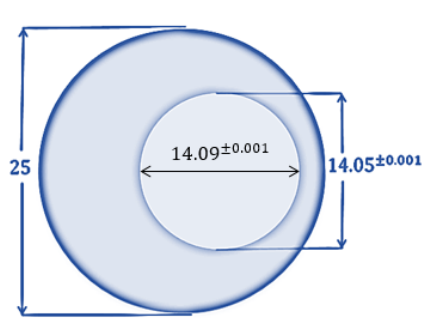
Figure 9. Offset-Ring-and-Plug sample